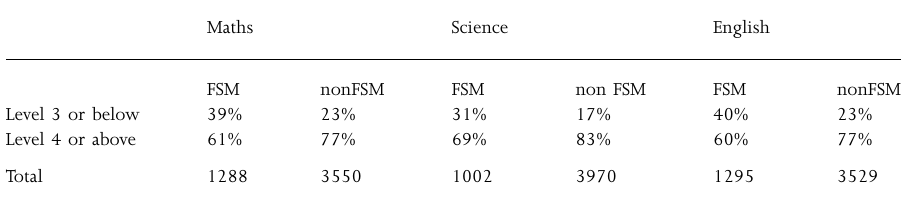
Table 4 Performance at KS2 by FSM status